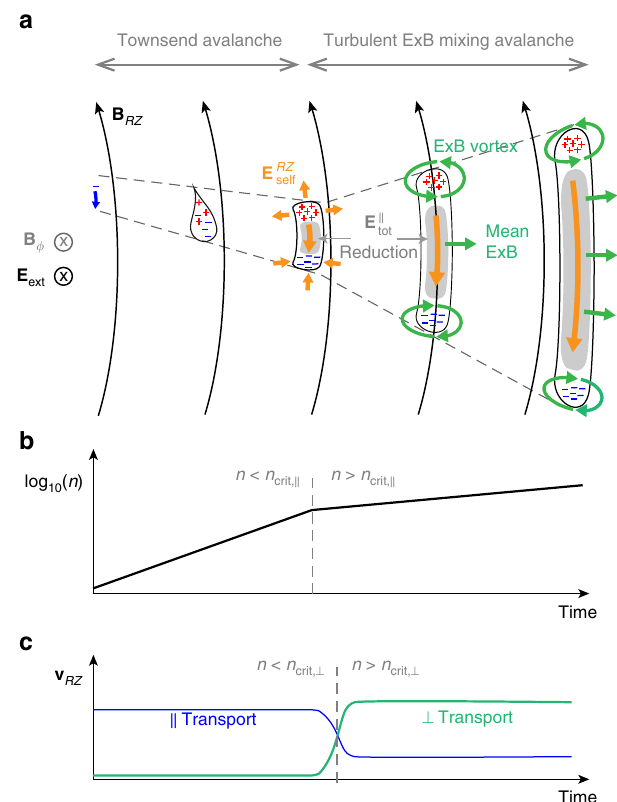
Fig. 5 Schematic diagram of turbulent ExB mixing avalanche. a Temporal plasma evolution in the RZ plane. b Temporal evolution of the plasma density in log-scale regarding the critical parallel density. c Temporal evolution of plasma transports in the RZ plane regarding the perpendicular critical density. The initial stage of the ohmic breakdown is the same as the Townsend avalanche that seed electrons move parallel to and increase exponentially along the magnetic fi eld lines. When the plasma density exceeds critical densities ( n and n ), the breakdown mechanism crit ; k crit ; ? changes to the turbulent ExB mixing avalanche due to the self-electric fi elds ( E RZ ) produced by the plasma. The plasma growth rate decreases self signi fi cantly and the enhanced ExB transports dominate the whole plasma transport. The faster turbulent ExB mixing rapidly diffuses the plasma along the magnetic fi eld line, and slower mean ExB moves the plasma across the fi eld lines (Figs. 3c, 5c, and see Methods for details). The dominant ExB transports strongly in fl uence the avalanche phenomena to differ completely from any electrical breakdown of the unmagnetized system. The roles of multi-scale ExB transports can be classi fi ed into two types that have distinct time and length scales: Faster turbulent ExB mixing and diffusion of the plasma along B RZ by fi ne structure of fl uctuating self-electric fi elds, and slower mean i . ExB fl ow across B RZ by broad structure of h E RZ self